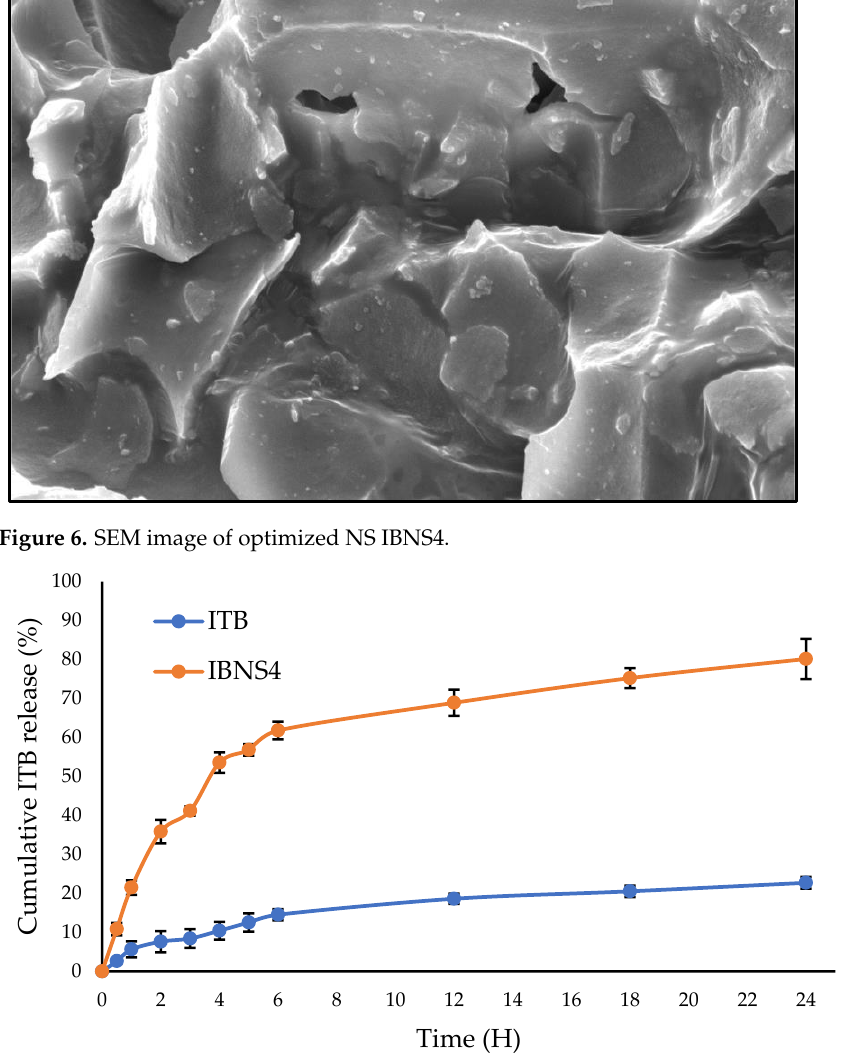
Figure 8. Cytotoxicity of pure Ibrutinib (ITB) and optimized ibrutinib-loaded nanosponges (IBNS4) after 48 h of incubation with MCF-7 cells at different concentrations (0.78–100 μg/mL) and control.